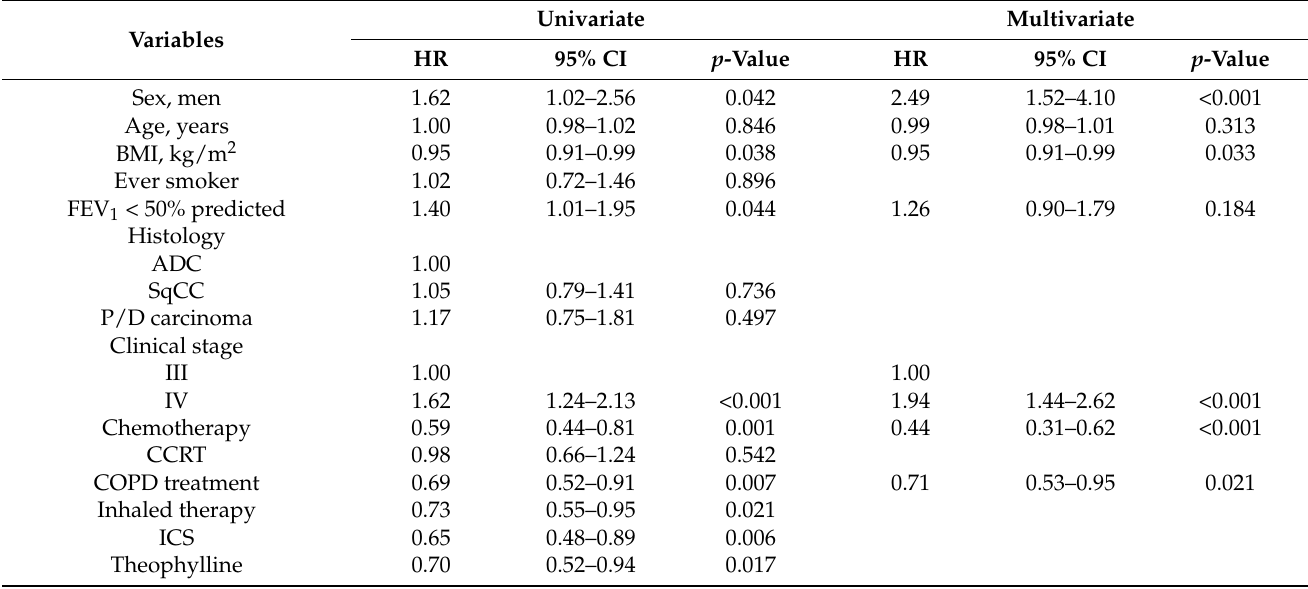
Table 4. Clinical factors associated with overall